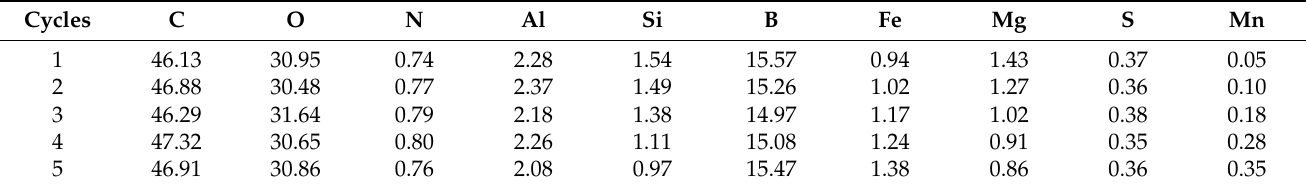
Table 6. Relative contents of various elements in TM/IHA composite particles after desorption with nitric acid and scanning by